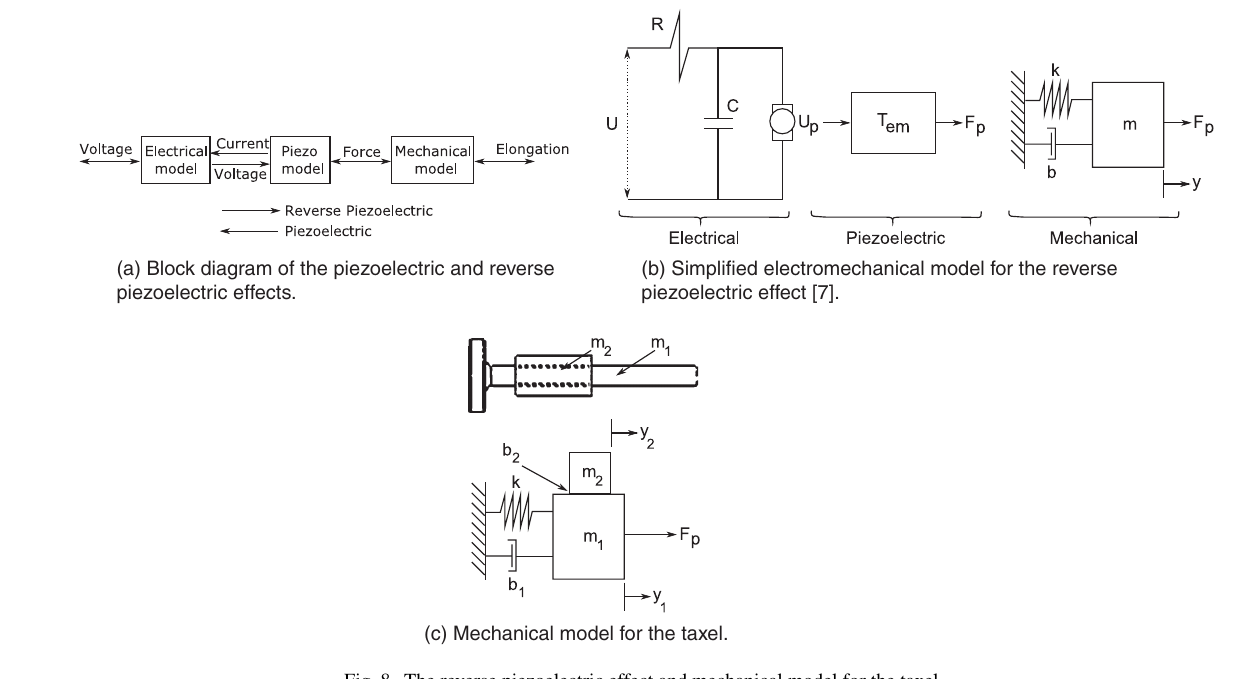
(a) Block diagram of the piezoelectric and reverse piezoelectric effects.